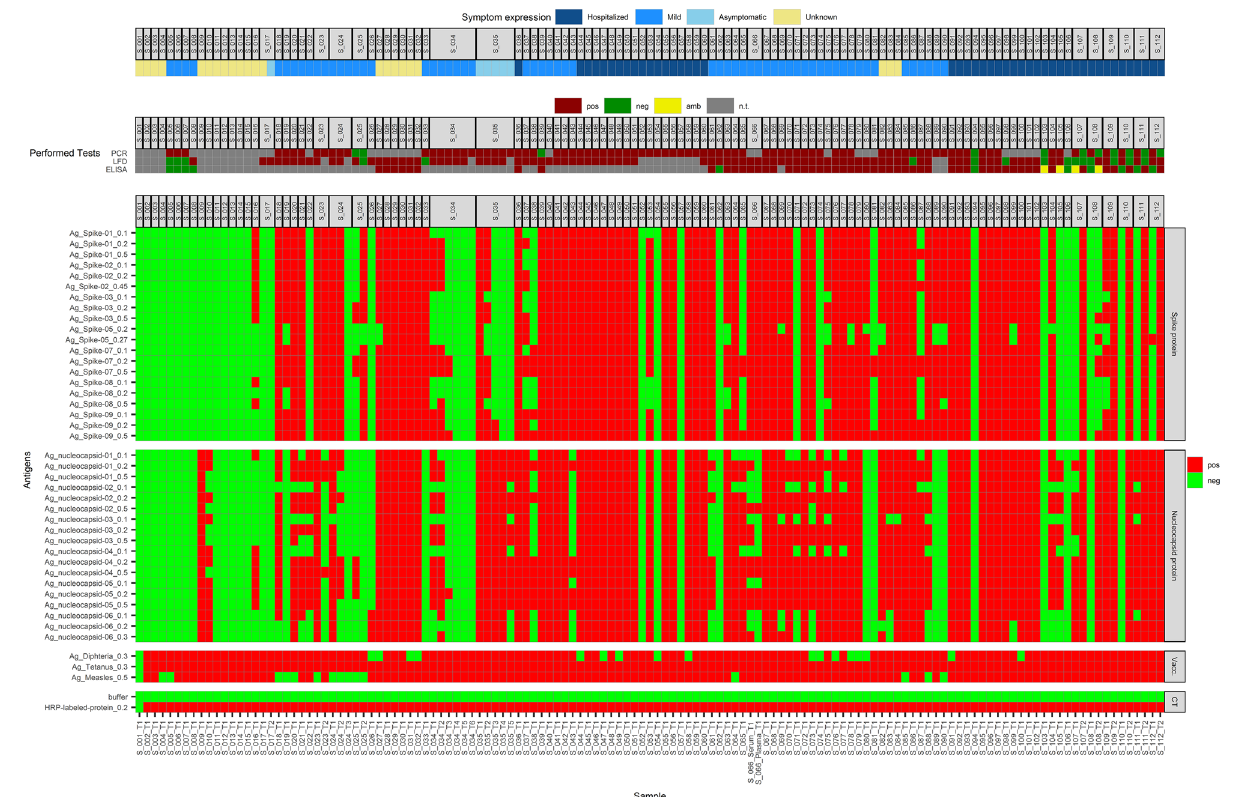
Figure 3. Shown are the results of the new SARS-CoV2-VAC antigen microarray and the available results of real-time (RT)-PCR, lateral flow (LF) and ELISA tests for a total of 112 sera tested, with some subjects tested multiple times, at different time